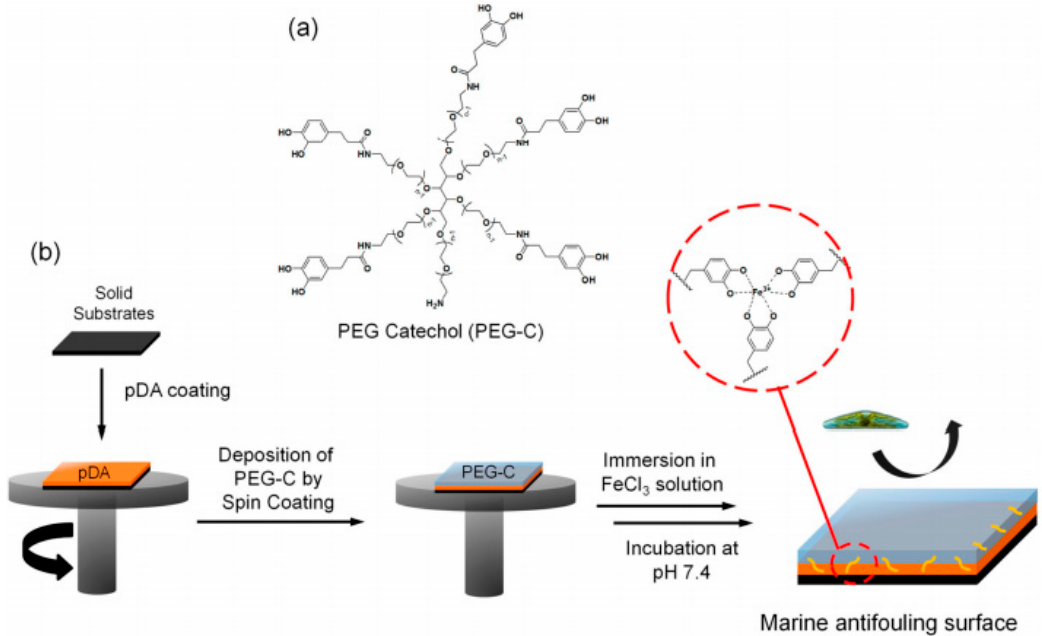
Figure 4. ( a ) Structure of 6-arm PEG-DOPA synthesised and used by Kang et al. [139]; ( b ) Schematic representation of the approach followed by Kang et al. to produce a PDA/PEG-DOPA/Fe 3+ multilayer coating. Reproduced with permission from reference [139]. Copyright (2018) American Chemical Society.